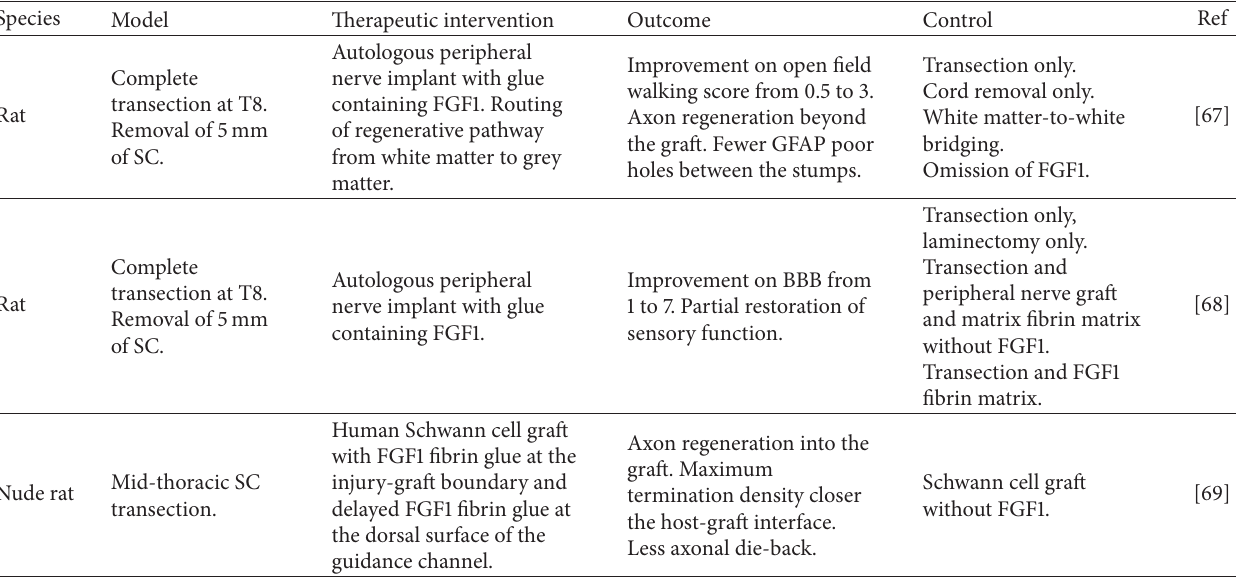
Table 1: Different strategies to promote regeneration using